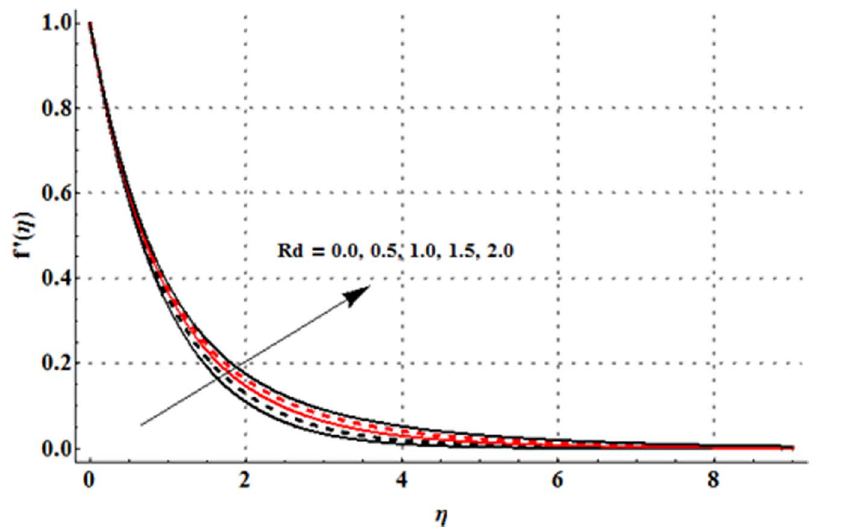
Figure 8. Influence of Rd on the velocity profile f ’ ( g ) when M ~ 0 : 6, b ~ 0 : 4, l 1 ~ 0 : 5, l ~ 0 : 3 ~ N , Pr ~ 1 : 2, S ~ 0 : 2 ~ S (cid:2) and Sc ~ 1 : 0 :